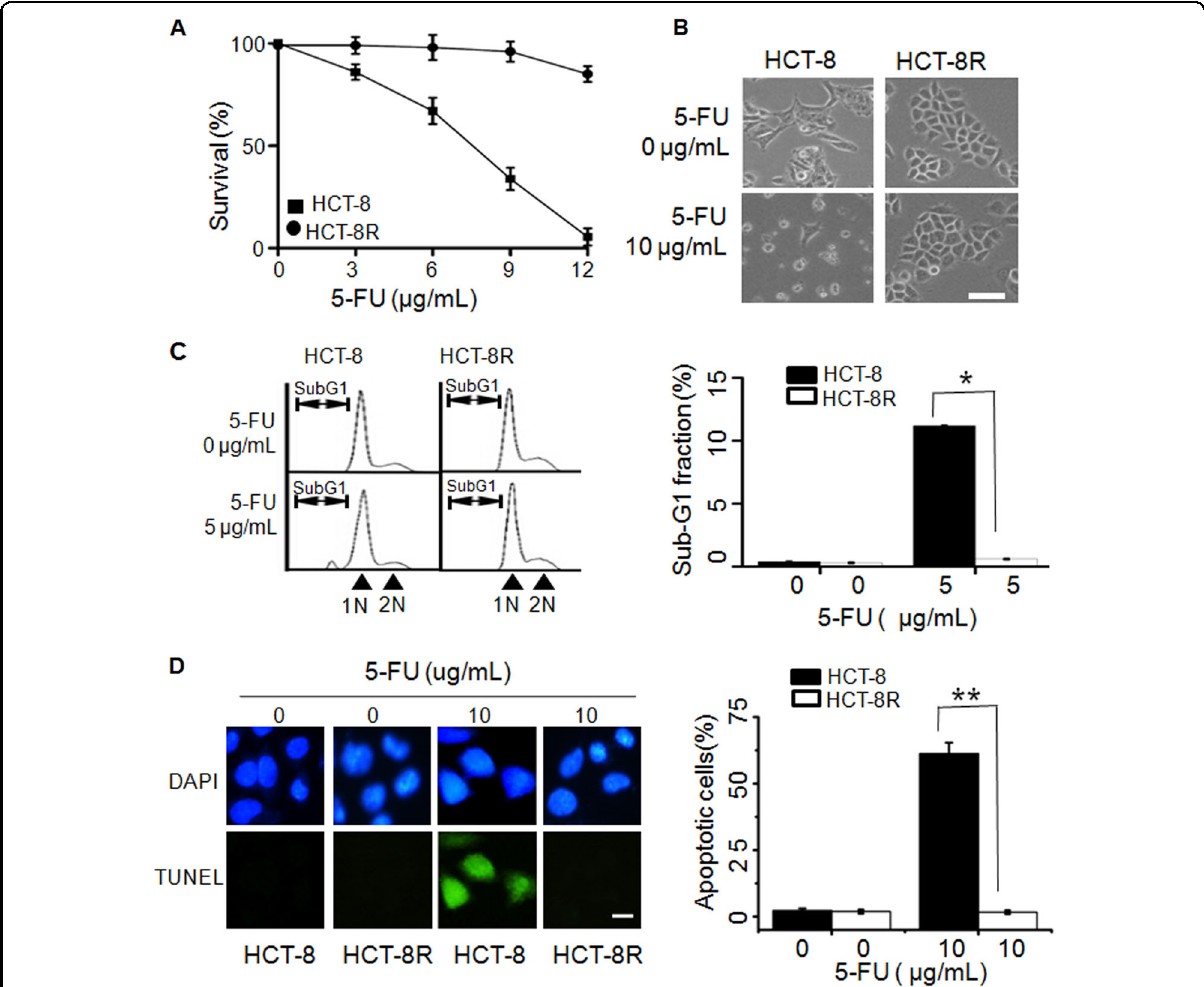
Fig. 1 Generation and characterization of 5-FU-resistant cells from HCT-8 cells. a Growth curve of HCT-8R and HCT-8 cells under 5-FU treatment. The data represent the means ± SD from three independent experiments. b Cell morphology of HCT-8R and HCT-8 cells (×400). Scale bar, 100 µm. c The result of FACS analysis shows the subG1 peak of HCT-8R and HCT-8 cells under treatment with 5 µg/mL 5-FU for 24 h. The FACS result shows the apoptotic ratio of cells induced by 5-FU treatment. HCT-8 WT control cell and HCT-8R resistant cell ratios were 8.1% and 0.2%, respectively. The data represent the means ± SD from three independent experiments. * P < 0.05. d TUNEL assay shows the apoptotic HCT-8 cells under 10 µg/mL 5-FU treatment for 48 h. Scale bar, 10 µm. The data represent the means ± SD from three independent experiments. ** P <